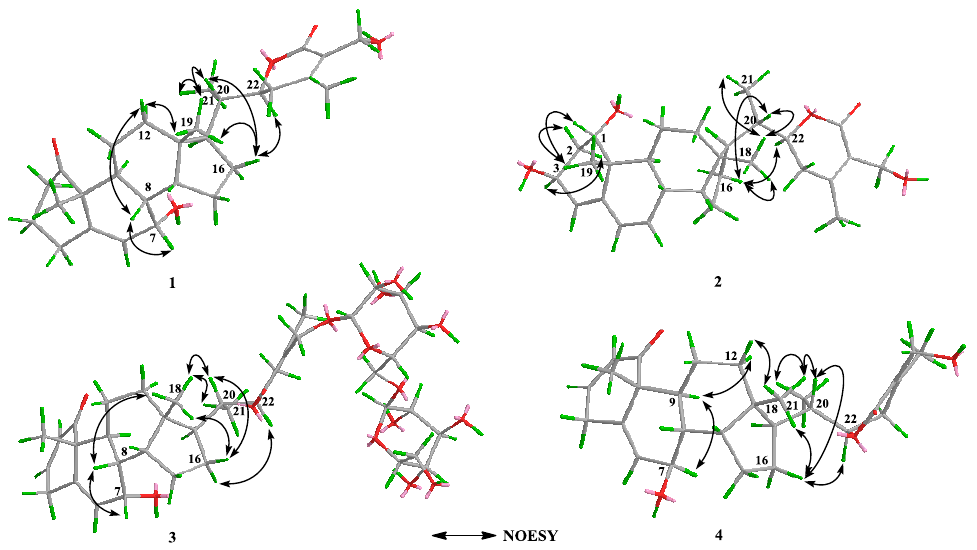
Figure 3. Key NOESY contacts of compounds 1 – 4